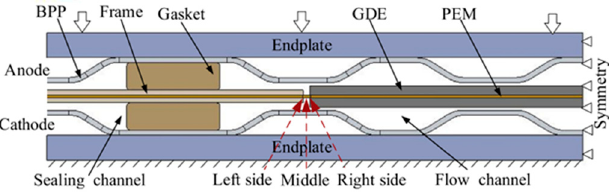
Figure 7. Cross-section view of the FE model of a PEMFC [72].